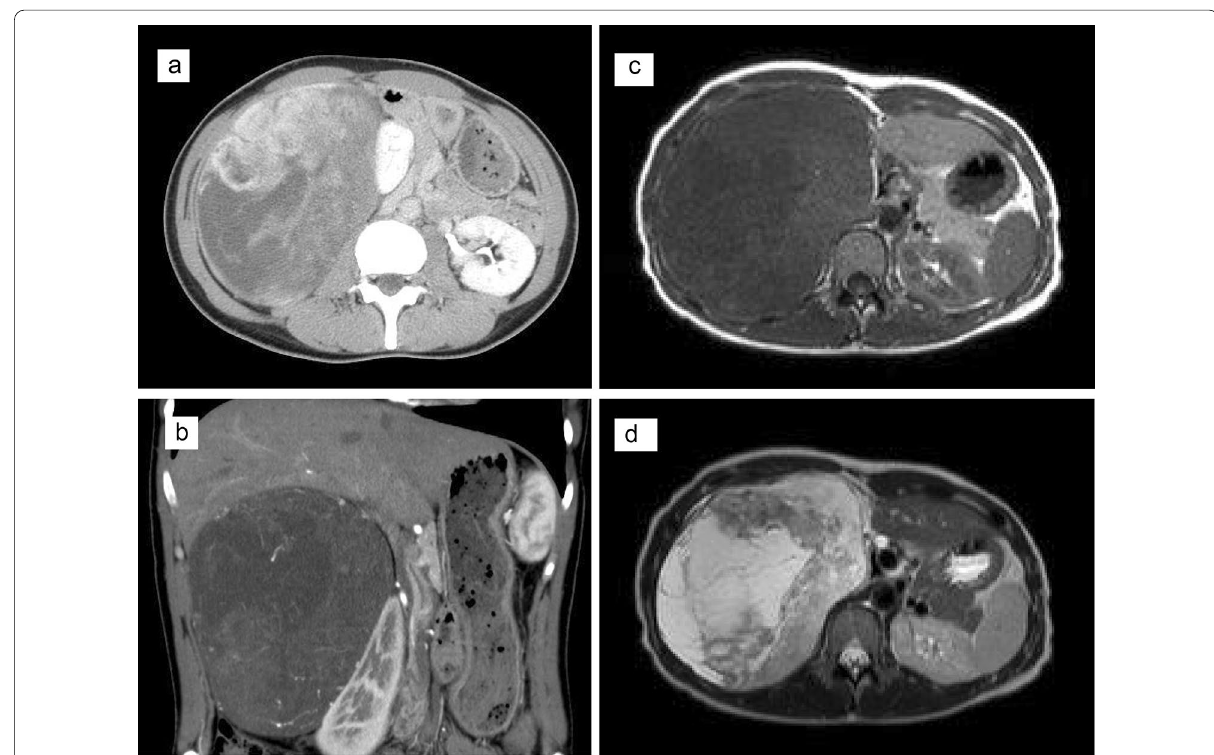
Fig. 1 CT and MRI imaging before treatment of primary tumor. a Abdominal CT shows a solid encapsulated mass with nonuniform internal structure approximately 16 16 10 cm, compressing the right kidney and duodenum to the caudal side; b contrast-enhanced CT coronary cut; × × c MRI shows association-clear, T1-weighted tumors with predominantly low to equal signals; d T2-weighted image showed a high signal intensity tumor with low signal intensity area